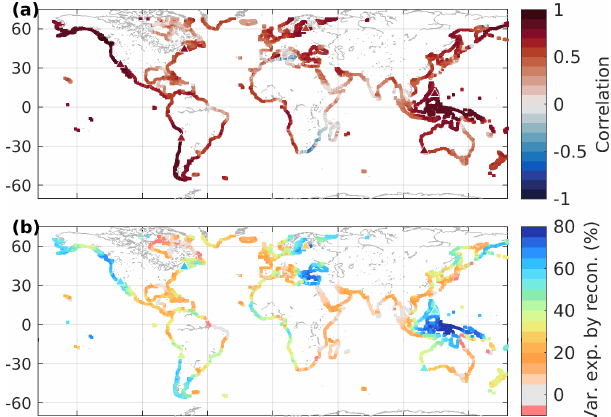
Figure 3. Comparison of decadal rolling sea-level trends from the NEMO model plus GRD, and reconstruction using only cli- mate indices: Pearson’s correlation coefficient (a) and variance ex- plained ( b ; %). The results here sum the reconstructed decadal trend from manometric sea level plus steric sea level by ocean basin. Tri- angles denote the locations of tide gauge observations shown in Fig.